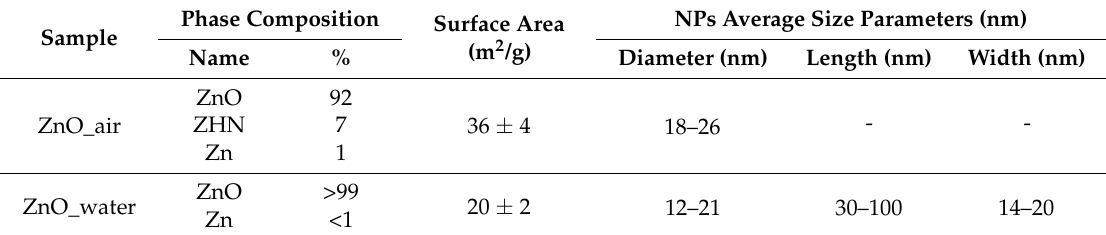
Figure 2. XRD patterns of PLA-prepared samples ZnO_water (blue), ZnO_air (red), and Zn and ZnO patterns from database (black). Inset shows pattern of sample ZnO_air and that of ZHN phase in a narrower range of 2 θ between 12 ◦ and 30 ◦ . Table 1. Structural characteristics and specific surface area values of prepared